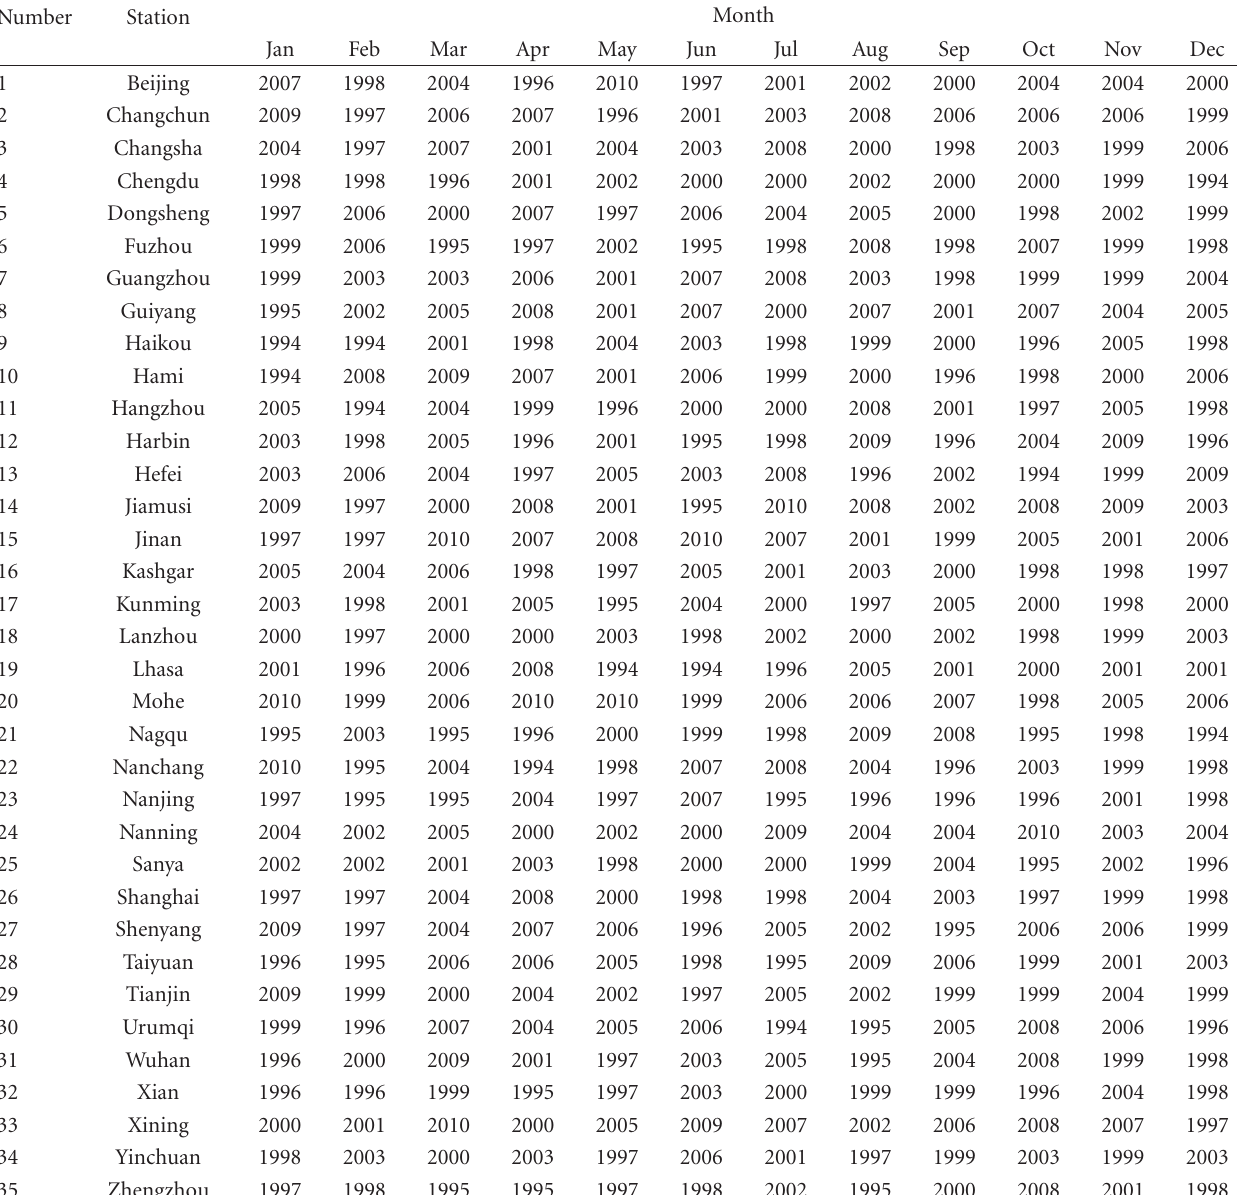
Table 3: Summary of the TMYs for the 35 stations in